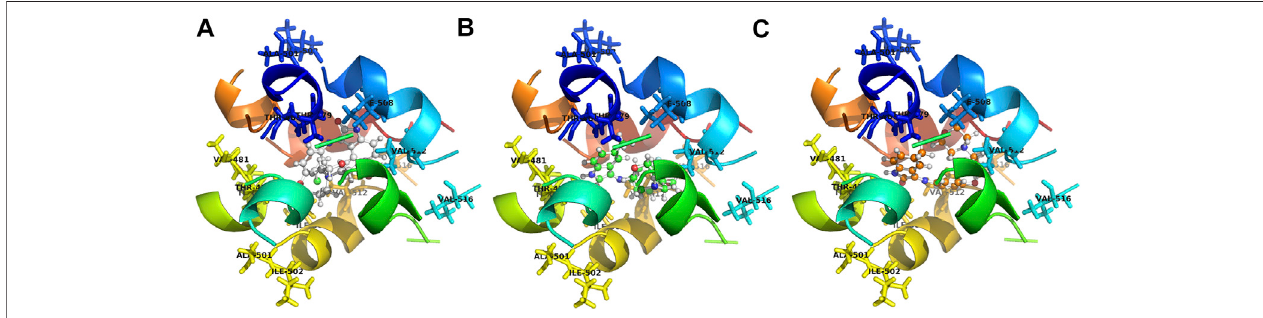
FIGURE 9 | Contrasting simulated molecular interaction models of compounds T16, T11 , T10 and their target Kv1.5 channel. The binding site of Kv1.5 channel is composed of the following amino acid residues: T479, T480, A501, I502, I508, V512, and V516 in the S6 domain and selectivity fi lter of a single subunit of the channel. The binding model of compounds T11 and T10 is similar, which is different from compound T16 . (A) compound T16 (C: gray, H: gray, O: red, N: blue); (B) compound T11 (C: green, H: gray, O: red, N: blue); (C) compound T10 (C: orange, H: gray, O: red, N: blue). A chain was shown in blue, B chain was shown in green, C chain was shown in yellow, and D chain was shown in